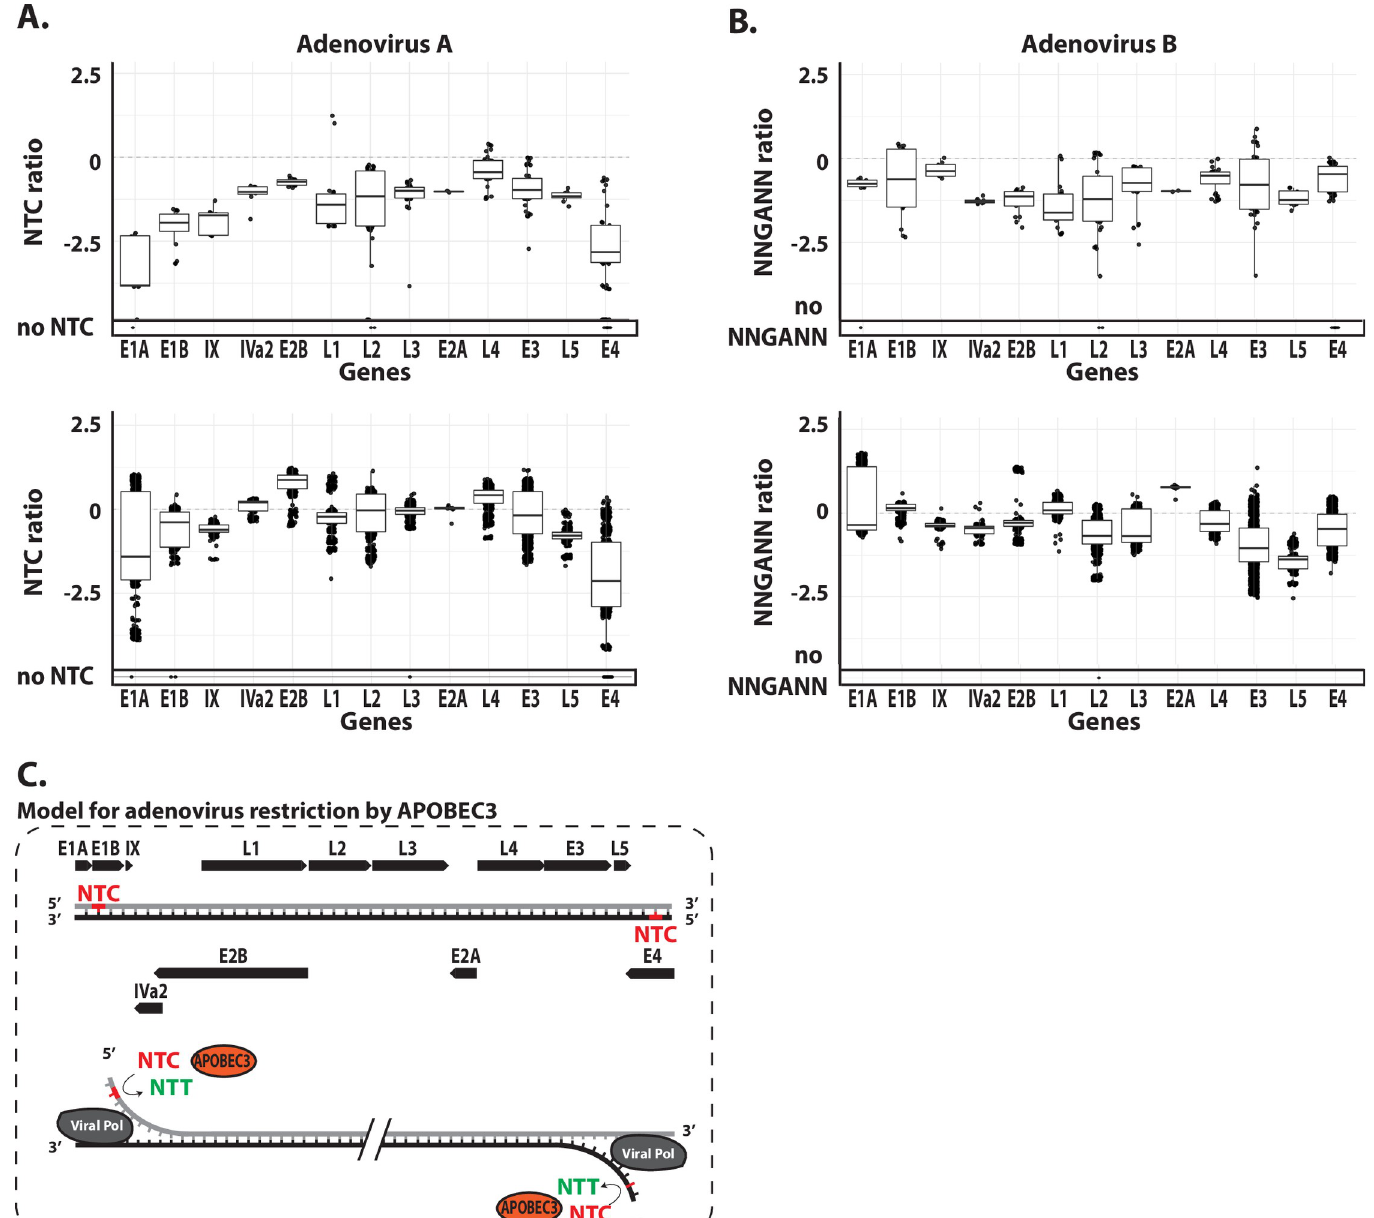
Fig 8. A3 footprint at the genomic ends of adenoviruses. NTC observed/expected ratios (panel A) and NNGANN observed/expected ratios (panel B) were calculated for the different genes of the Adenovirus A and B (each point represents a unique coding sequence). C. Proposed model for A3-editing activity on the adenovirus genome. Genes are represented by black arrows. A3-favored NTC sequence is represented in red and the NTT edited product in